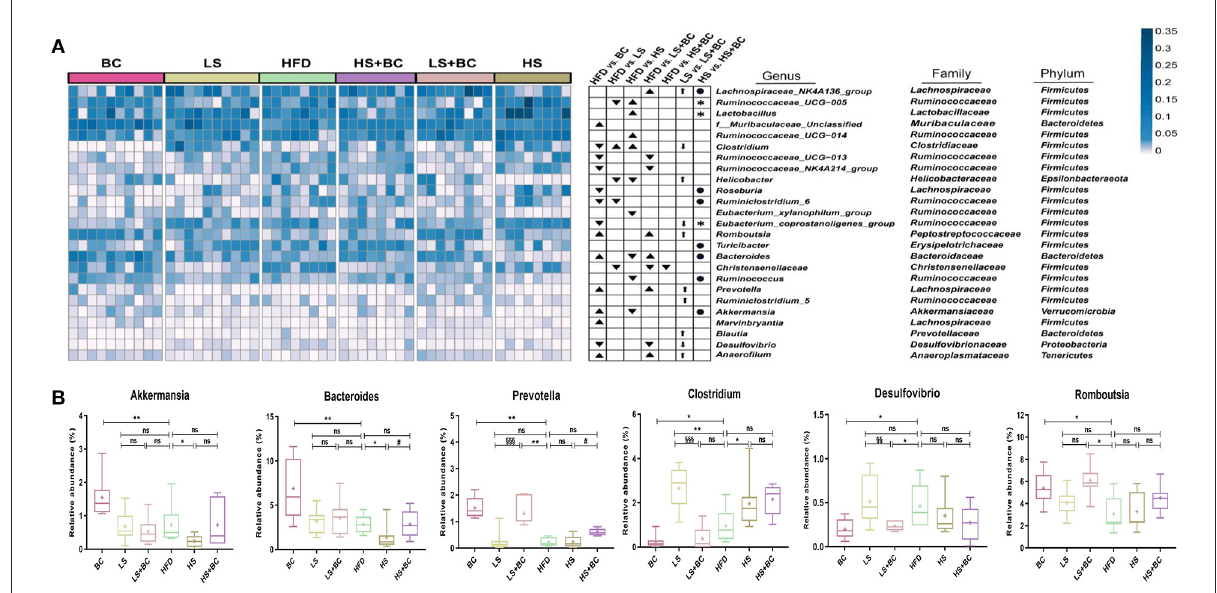
FIGURE3 Effect of BCPs treatment on gut microbiota structure of genera level in HFD-induced obese rats. (A) Heatmap showing the abundance of 25 genera significantly altered after BC treatment; N represent more abundant in BC group, LS group, HS group, LS + BC group and HS + BC group relative to HFD group; H represent less abundant in BC group, LS group, HS group, LS + BC group and HS + BC group relative to HFD group; ↑ represent more abundant in LS + BC group relative to LS group; ↓ represent less abundant in LS + BC group relative to LS group; • represent more abundant in HS + BC group relative to HS group; represent less abundant in HS + BC group relative to HS group; (B) Changes in the relative abundance of representative genera. Values are means ± SEMs. * p < 0.05, ** p < 0.01 and *** p < 0.001 when comparing other groups with HFD group, # p < 0.05, ## p < 0.01, ### p < 0.001 when comparing HS group with HS + BC group, § p < 0.05, §§ p < 0.01, §§§ p < 0.001 when comparing LS group with LS + BC